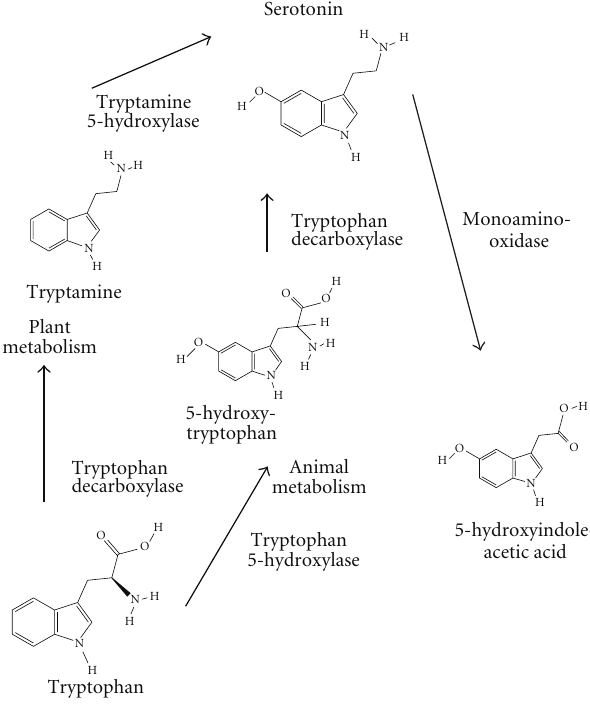
Figure 2: Serotonin metabolism. Tryptophan is the precursor for serotonin synthesis, with di ff erent enzymatic reactions in plant and animals [6]; hydroxylation is the rate limiting step (enzyme medi- ated by tryptophan hydroxylase in animals or tryptamine hydrox- ylase in plants), while decarboxylation is a rapid conversion by the aromatic amino acid decarboxylase (tryptophan decarboxylase). The catabolic metabolite of serotonin is 5-hydroxyindoleacetic acid, via 5-hydroxyindole acetaldehyde enzymatically converted by the membrane-bound mitochondrial flavoprotein monoamino oxi- dase. Modified images from NCBI PubChem Substance